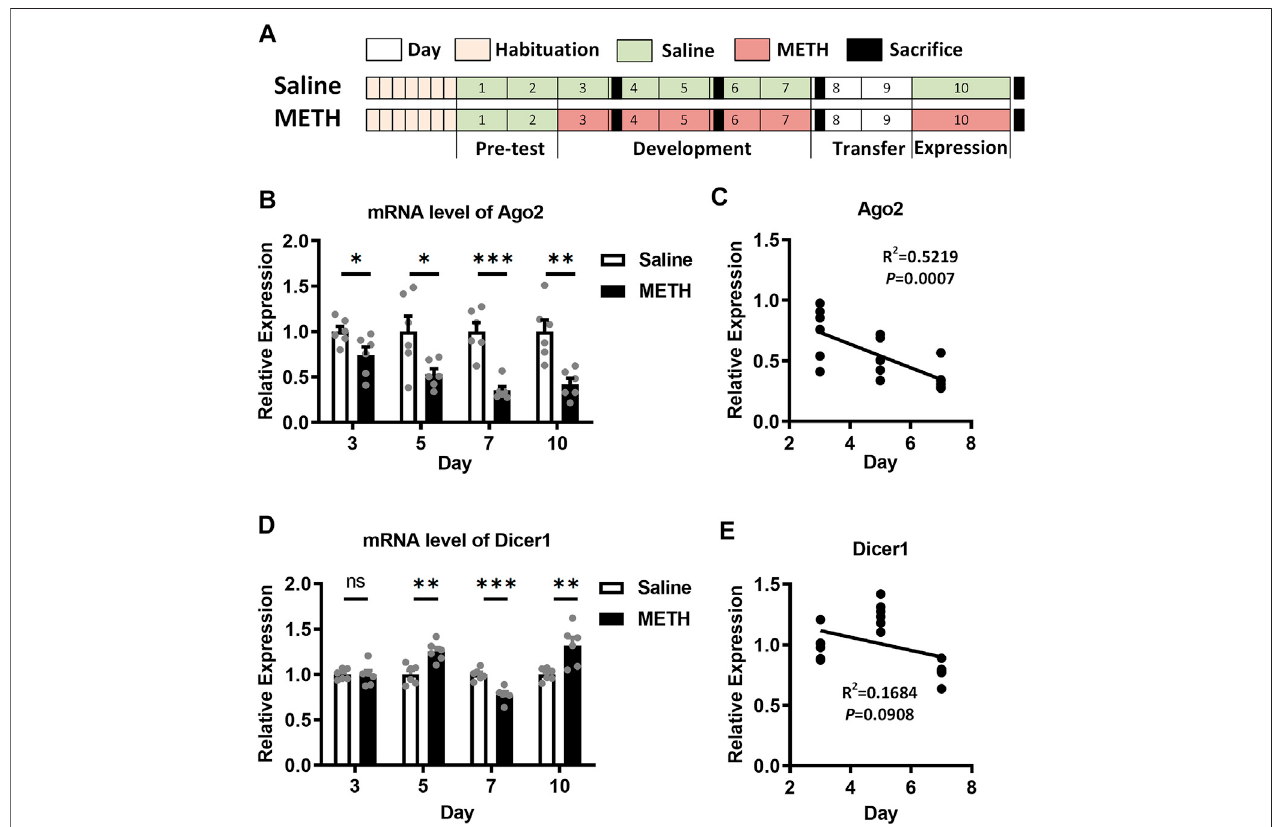
FIGURE 1 | Expression of Ago2 and Dicer1 in the NAc of METH-sensitized mice. (A) Illustrations showing the schedule and procedure of the METH sensitization model. (B) Differential expression ofAgo2 mRNA inthe NAc ofmice inresponseto METH. (C) Pearson ’ scorrelation analyses betweenAgo2expression and days in the development phase of METH sensitization. (D) Differential expression of Dicer1 mRNA in the NAc of mice in response to METH. (E) Pearson ’ s correlation analyses between Dicer1 expression and days in the development phase of METH sensitization. Student ’ s t -test: * p < 0.05, ** p < 0.01, and *** p < 0.001 compared with the saline group. The data are presented as the mean ± SEM, n (cid:2) 6. NAc, nucleus accumbens; METH sensitization, METH-induced locomotor